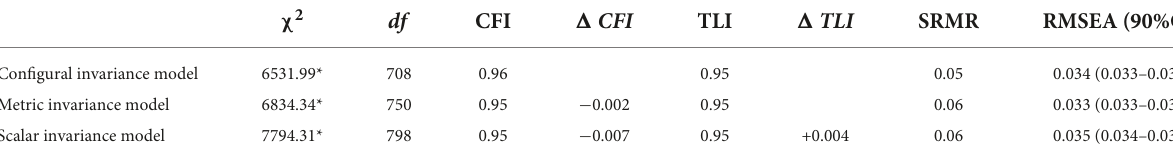
TABLE 4 Testing for factorial invariance across three time points.